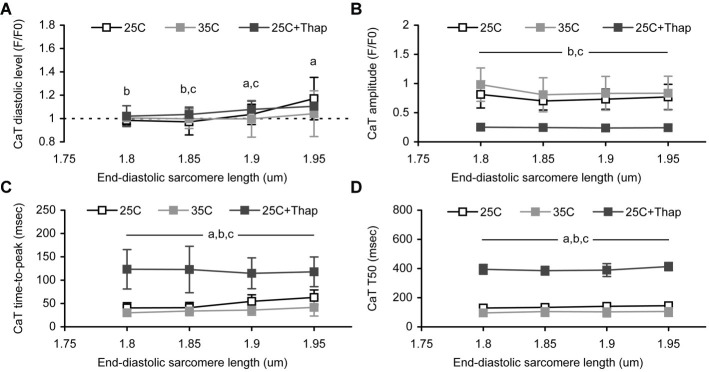
The sarcomere length dependences of Ca-transient (CaT) characteristics obtained in auxotonically contracting isolated rat ventricular cells at room temperature in normal saline (“25C,” N = 4 animals, n = 21 cells); at near-physiological temperature in normal saline (“35C,” N = 3 animals, n = 24 cells); and at room temperature with depleted SERCA2a (“25C + Thap,” N = 3 animals, n = 18 cells). (A) The diastolic level. (B) The amplitude. (C) The time-to-peak. (D) The time-to-decline from peak to 50% amplitude (T50). Data shown as mean ± S.D. Horizontal lines with the significance symbol(s) show the range where this significance is found. a – significant difference between “25C” and “35C”; b – significant difference between “25C” and “25C + Thap”; c – significant difference between “35C” and “25C + Thap” (Mann–Whitney U-test, p < 0.05).